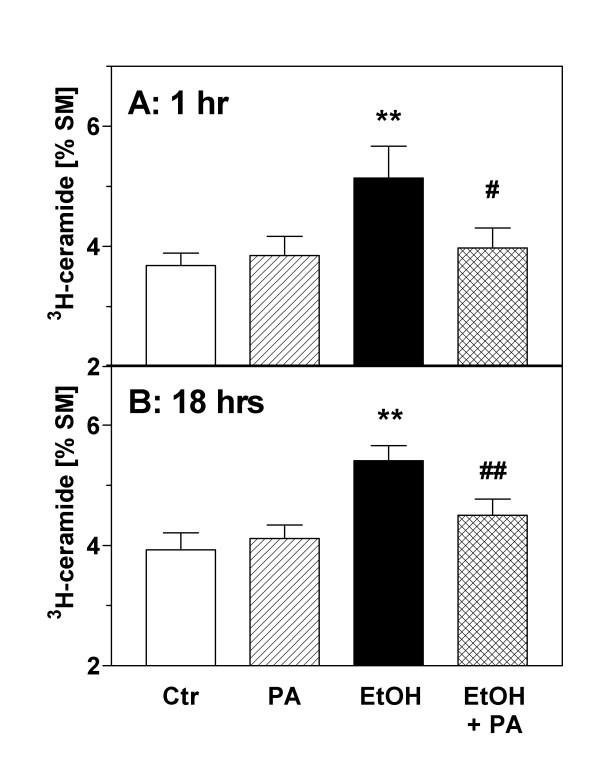
Effects of phosphatidic acid on ceramide formation in astrocytes. Astrocytes were prelabeled with [3H]-serine for 72 hours, washed and treated with PA (200 μM) or ethanol (EtOH, 0.3 % v/v) during transient permeabilization with streptolysin-O (144 ng/ml) in calcium-free medium. After 15 min, the cultures were washed and re-exposed to calcium-containing medium to initiate pore repair. After (A) 1 hour and (B) 18 hours, the cells were extracted with methanol/chloroform (2:1), phospholipids were separated by TLC, and the radioactivity associated with ceramide and sphingomyelin was determined by liquid scintillation counting. During the experiments, PA was only present for 15 min during cell permeabilization whereas ethanol was present throughout the incubation period. Data (N = 9) are means ± S.E.M. and are expressed as [%] ceramide/sphingomyelin. Statistics: Repeated measures ANOVA, (A) F3,35 = 5.52, p = 0.005; (B) F3,35 = 14.5, p < 0.0001. **, p < 0.01 vs. controls ("Ctr"). #, p < 0.05; ##, p < 0.01 vs. effect of ethanol (Tukey-Kramer multiple comparisons test).